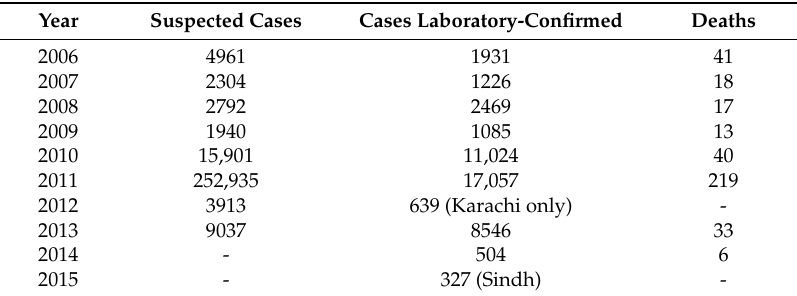
Table 5. Dengue fever cases reported in